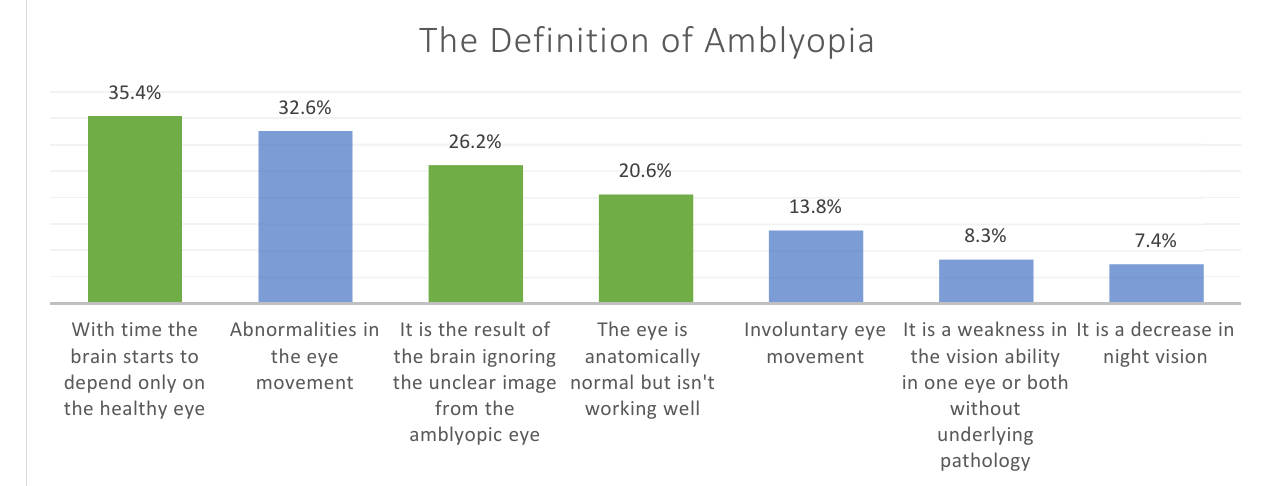
Figure 1. The proportions of participants’ responses for their knowledge regarding the definition of amblyopia, where they had the option to choose more than one answer. (The correct answers are represented by green bars and the incorrect answers by blue bars).